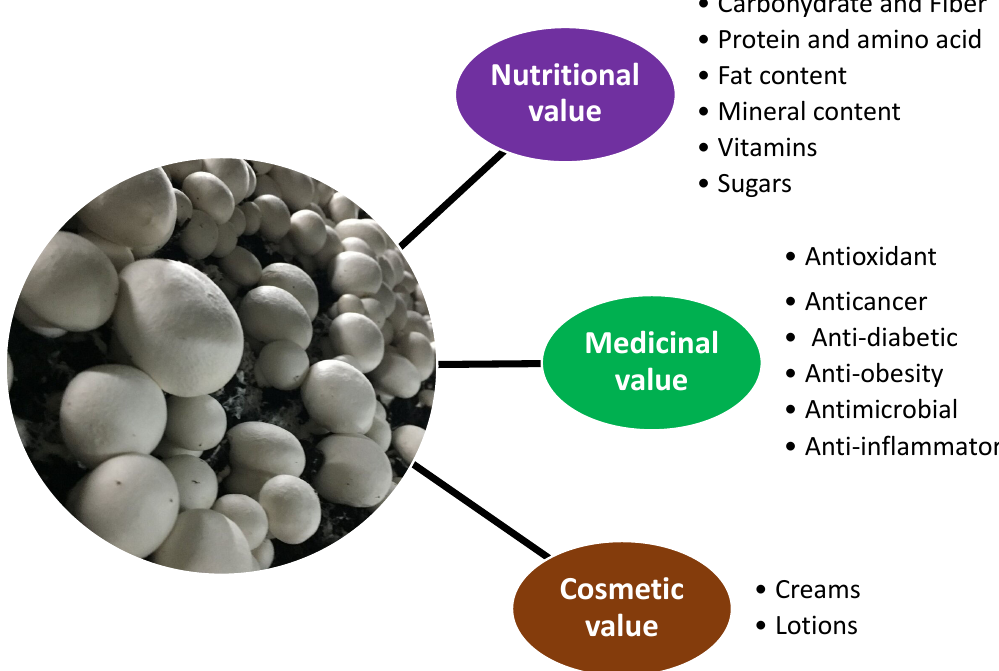
Figure 1. A summary of nutritional, medicinal, and cosmetic value of Agaricus bisporus.